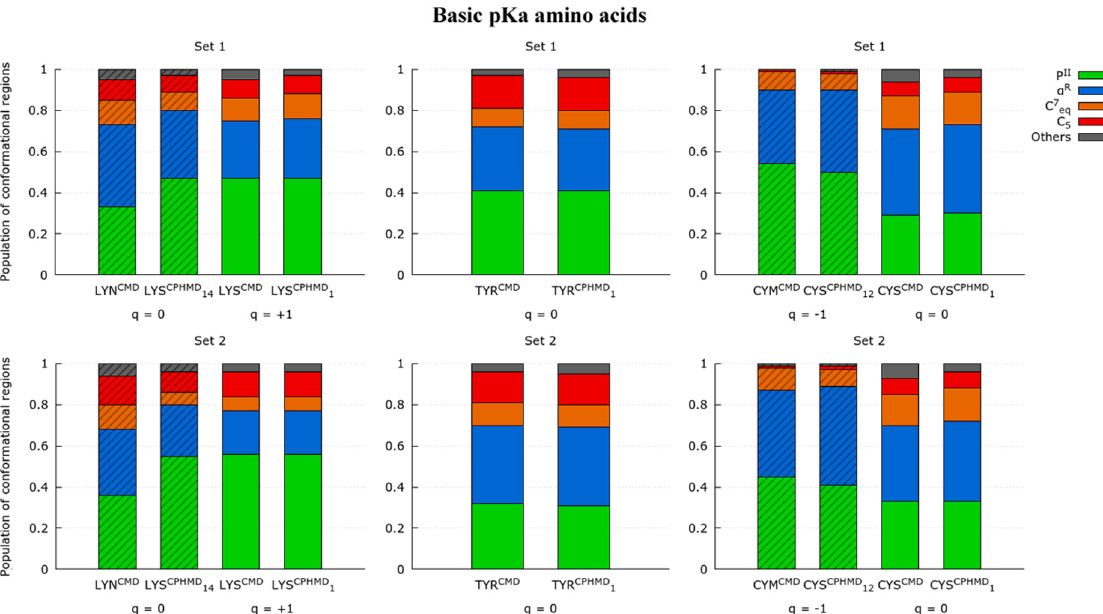
Figure 3. Ratio of the fourth most populated conformational regions (P II , α R , C 7 eq , and C 5 in green, blue, orange, and red, respectively) in the Ramachandran map of the LYS, TYR, and CYS amino acids. The labeling indicates the residue, the simulation method (in the superscript), and the pH (in the subscript, only for the CPHMD simulations). Subtitles indicate the set of dihedrals corresponding to monomer 1 (N-terminal) or monomer 2 (C-terminal amino acid). The total charge of the tripeptide is indicated below the systems (q = − 1, 0 or +1). The box style (striped or solid) indicates those systems in the same protonation state, independently of the method used. The ‘others’ classification (gray) includes the conformational regions β 2 , α ’, α D , α L , and C 7axial .